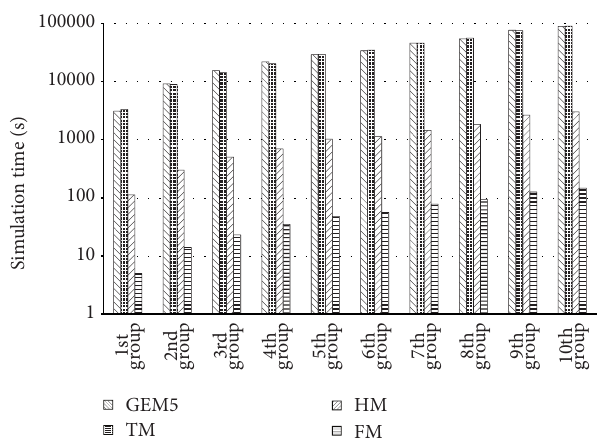
Figure 9: Simulation